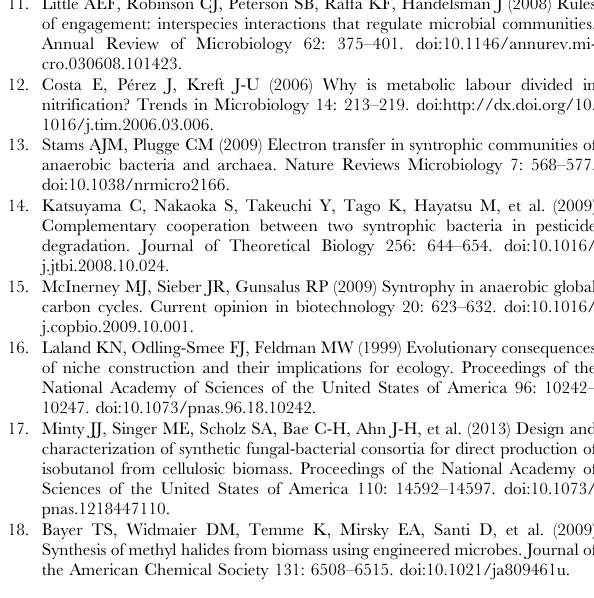
(TIF) Figure S9 The growth penalty associated with secretion of emergent metabolites. The distribution of the relative growth rate of the producer when forced to secrete emergent metabolites in mono-culture compared to its growth rate with no constraints on secretion is illustrated. The leftmost bin represents cases in which the producer is not able to grow when forcing the secretion of the emergent metabolite in mono-culture. (TIF) Figure S10 Confirming the Goldilocks principle of emergent biosynthetic capacity in 500 ‘universally neutral’ media (see Text S1). The plot details are as described in Figure 7. (TIF) Table S1 A list of all the SEED models used in our study. (PDF) Text S1 Supporting information, including a derivation of equation (6), an analysis of the impact of emergent biosynthetic capacity on growth, an analysis of the role of the partner in emergent biosynthetic capacity, and a validation of the Goldilocks principle in universally neutral media.